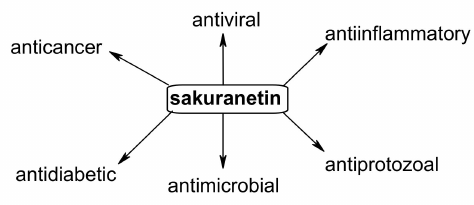
Figure 1. Biological activity of